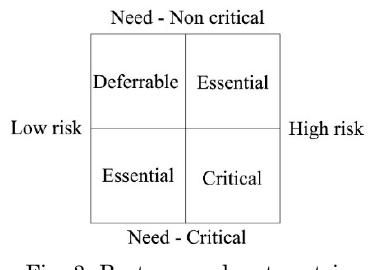
Fig. 3. Boston quadrant matrix Table 1. Example of potential risk level assessment